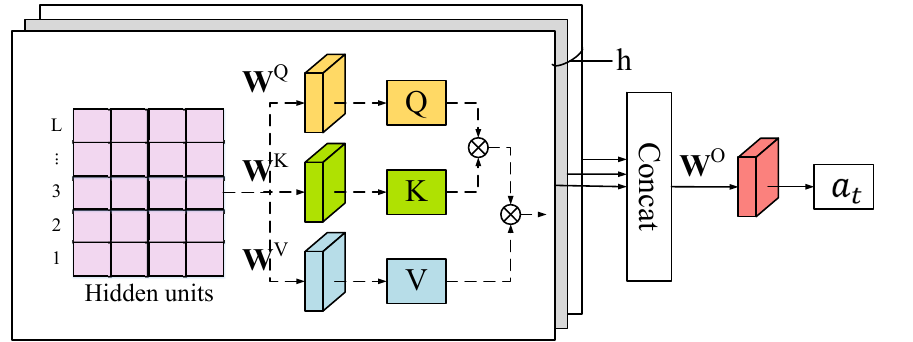
Figure 6. The framework of the MHA